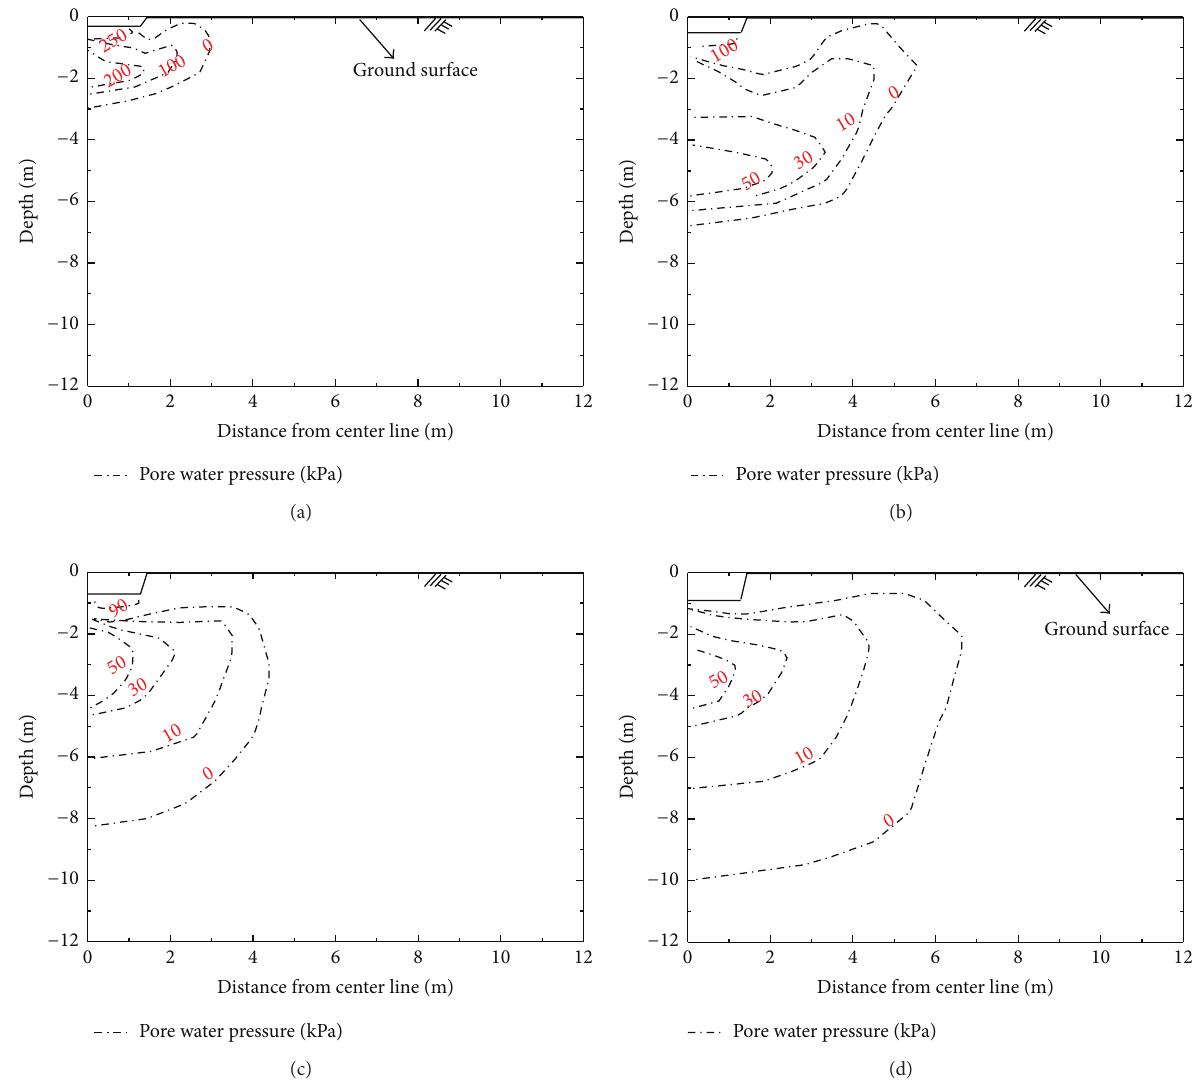
Figure 10: Contour lines of pore water pressure for the first blow: (a) 0.05 s, (b) 0.1s, (c) 0.2 s, and (d) 0.3